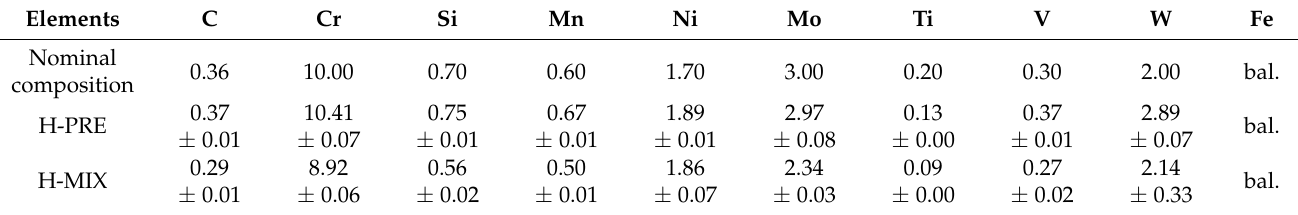
Table 1. Chemical composition in mass% of the used hot work tool